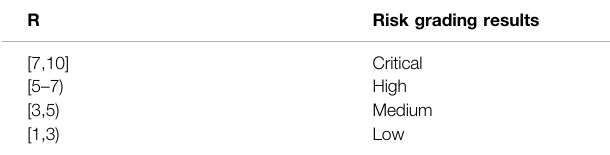
TABLE 2 | Risk assessment grading standrads.